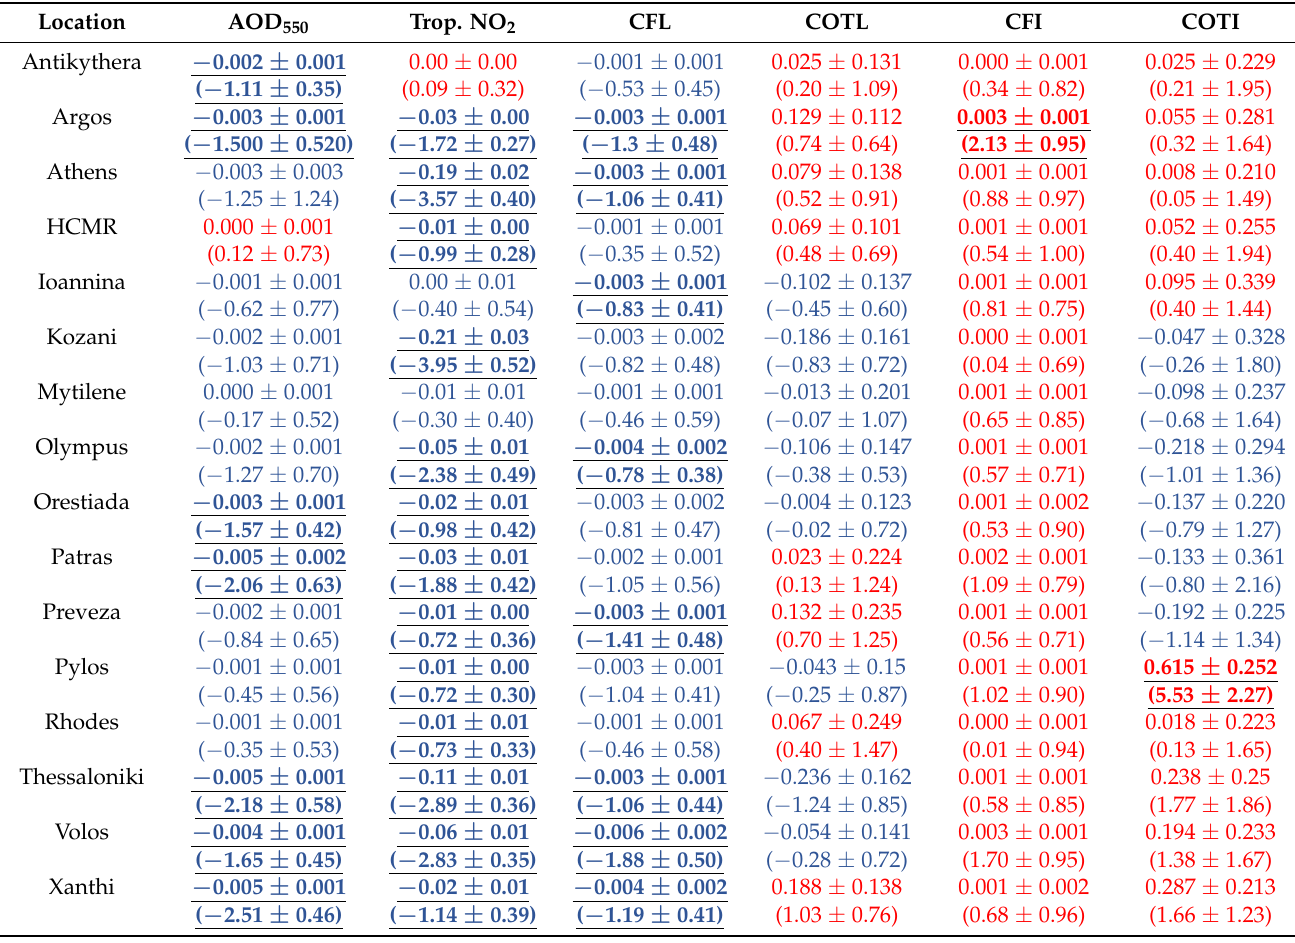
Table 4. Trends of AOD 550 (in 1/year), tropospheric NO 2 VCD (in 10 15 molecules/cm 2 /year), liquid cloud fraction (CFL; in 1/year), liquid cloud optical thickness (COTL; in 1/year), ice cloud fraction (CFI; in 1/year) and ice cloud optical thickness (COTI; in 1/year) for the period 2005–2019 with the corresponding relative to the first-year trends (in parentheses; in %/year) and ± 1 σ . Red/blue color denotes positive/negative trends, respectively. Bold underlined characters are used for statistically significant trends at the 95% confidence level. Aerosol- and cloud-related parameters are from MODIS/Aqua and tropospheric NO 2 from